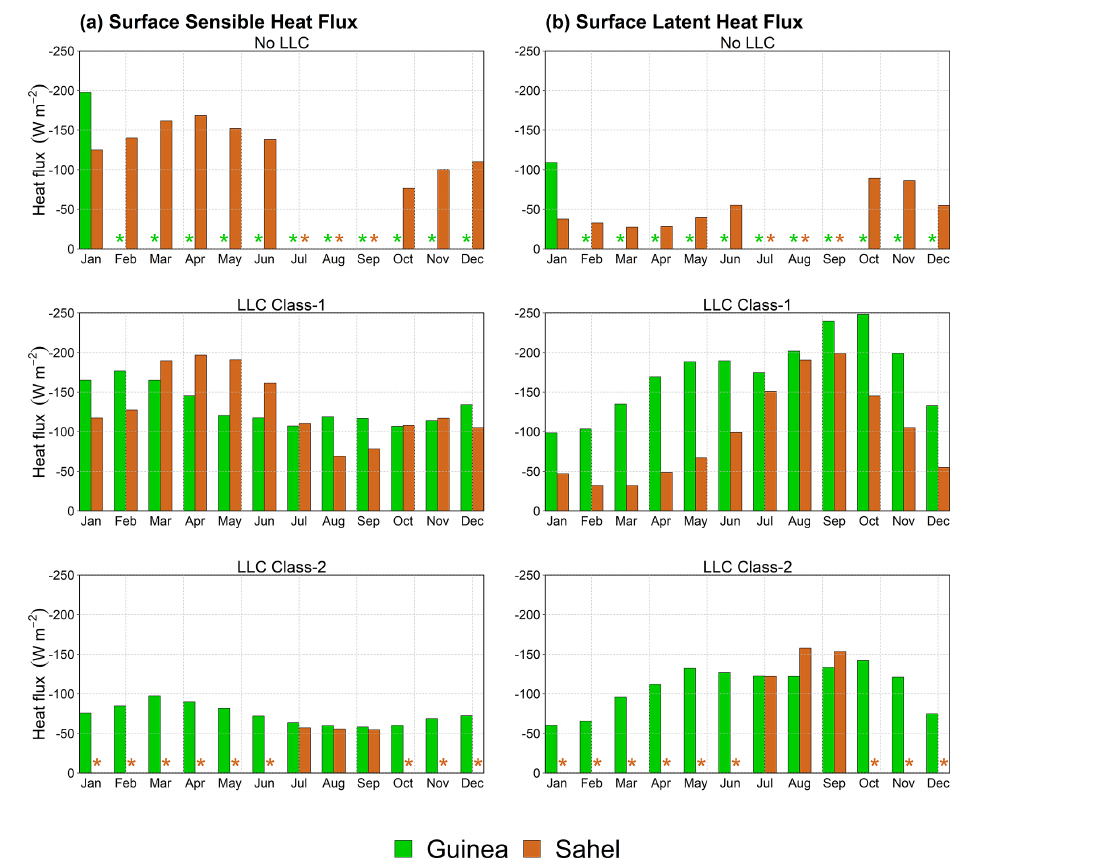
Figure 8. Monthly mean (a) surface sensible heat and (b) surface latent heat fluxes computed in the Guinea and Sahel regions during the occurrence of the three LLC classes from 2006 to 2015. The orange and green stars mean that there was no occurrence of the particular LLC class events in the region during that month; hence the composites were not computed. Only occurrences that last for at least 6 consecutive hours are